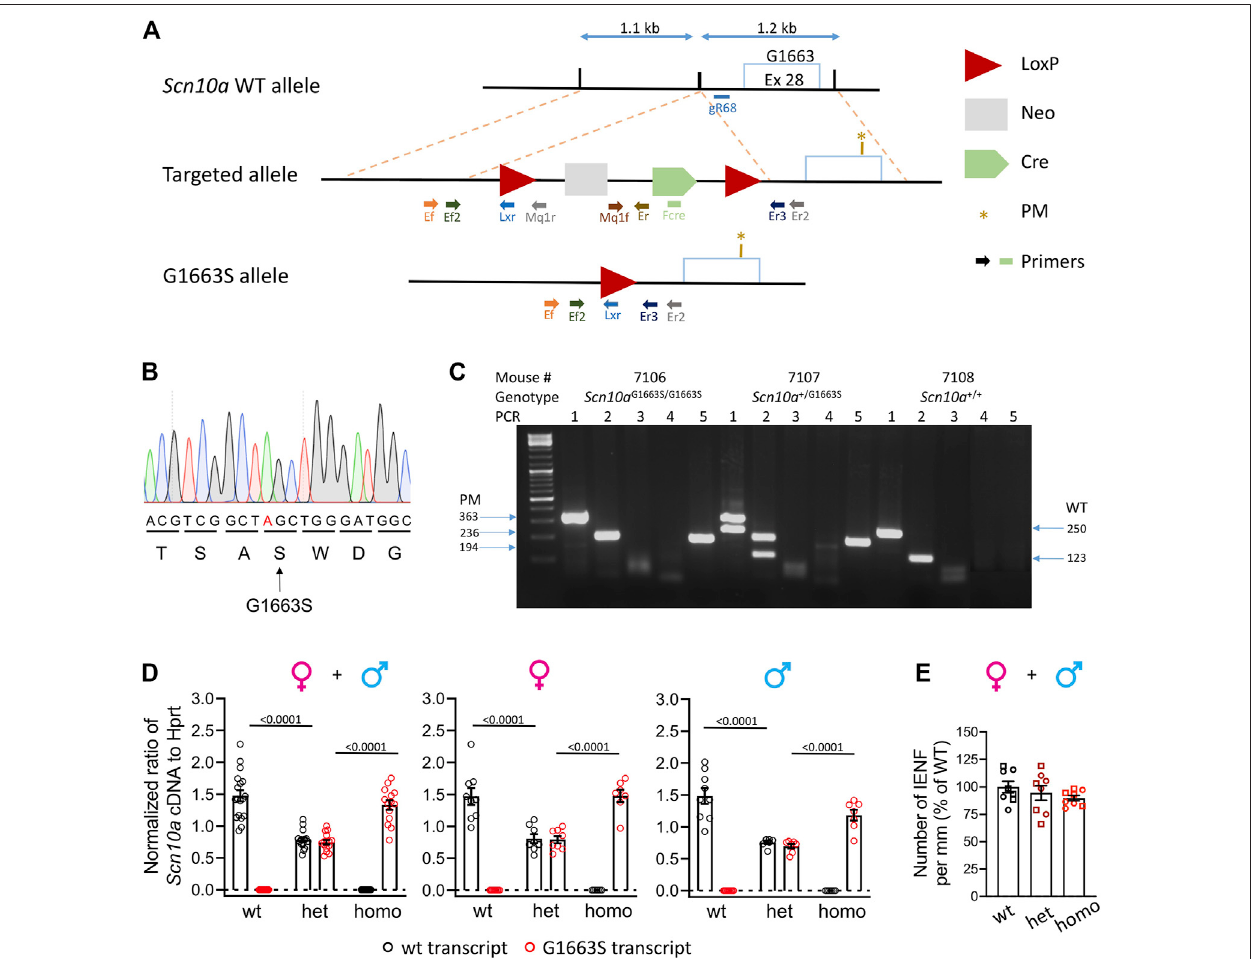
FIGURE 1 | Generation and validation of the Scn10a G1663S mouse model. (A) Targeting strategy by homologous recombination. The scheme shows the Scn10a WT allele, the targeted allele, and the G1663S knock-in allele. The targeted allele was engineered bearing two homology arms of the original Scn10a endogenous gene and an auto-selection cassette. The 3 ′ arm of homology (1.2 kb) consisted of a part of intron 28 and of a part of exon 28 bearing the S1663 mutation. The 3 ′ arm was clonedintoatargetingvectorcontainingtheloxP- fl anked( “ fl oxed ” )neocassette.The5 ′ armofhomology(1.1 kb)consistedofpartofintron28andwasclonedinto the vector containing the auto-selection cassette and the 3 ′ arm. The fi nal mutant allele was obtained after excision of the selection cassette. Light blue box: Exon 28 containing the locus G1663/S1663; the PM was indicated with a brown star; blue double arrow lines: indicate size of the arms; red triangles: LoxP sites; light gray box: neomycin selection cassette; green pentagon: Cre cassette. Different-colored lightning block arrows show the primers used for genotyping. The green rectangle indicates the primer located in the Cre cassette (Fcre) used for DNA sequencing. (B) Mutant allele sequence characterized through Sanger sequencing on a positive ES clone using a speci fi c primer located in the Cre cassette (Fcre) amplifying only the mutant allele. The mutated nucleotide is indicated in red. (C) Example of genotyping results on electrophoresis gel showing three different genotypes. For all samples, PCR3 and 4 gave no bands indicating that the selection marker was excised. For sample #7106: PCR1 and 2 gave one band each at 363 and 236 bp, respectively. PCR5 gave one band of 194 bp. These reactions con fi rm that one LoxP site is still there and theScn10a G1663S/G1663S genotype. Forsample#7107:PCR1 and 2gave twobandseach at 363and 250 bpand 236and 123 bp,respectively.Onebandat 194bpforPCR5.ThesePCRreactionscon fi rmthatoneLoxPsiteisstillthereandtheScn10a +/G1663S genotype.Forsample#7108:PCR1and2gaveonebandeachat 250 and 123 bp, respectively. No band for PCR5, con fi rming the wild-type genotype. (D) Wild-type and G1663S allele mRNA expression in DRG of Scn10a G1663S heterozygous and homozygous mutant mice. Scn10a mRNA expression was normalized to Hprt expression. Homozygous mutant mice expressed Scn10a G1663S transcript at levels comparable to wt transcript expression, and heterozygous mice express half level of each transcript type. Females, n (cid:1) 7 – 9/group; males, n (cid:1) 7 – 9/ group. One-way ANOVA analysis was followed by Sidak ’ s multiple-comparison tests. The bars and p values indicate signi fi cant differences ( p < 0.05) between wt and heterozygousmutantmice,andbetweenheterozygousandhomozygousmutantmiceinSidak ’ smultiple-comparisontests.See SupplementaryTableS3 fordetailed statisticalanalysis. (E) TheG1663SmutantmiceshowedcomparableIENFDcomparedtowt.Dataareexpressedas%ofthemeanofIENFDofeachanimaltothemean of wtofthesamesex. Circles areused forfemales and squaresfor males. n (cid:1) 4mice per genotype and sex.The two-way ANOVAforthe effects ofgenotype and sexas well as one-way ANOVA on grouped sexes showed no sex or genotype effect. Data are expressed as means ± SEM in all panels. See Supplementary Table S4 for detailed statistical